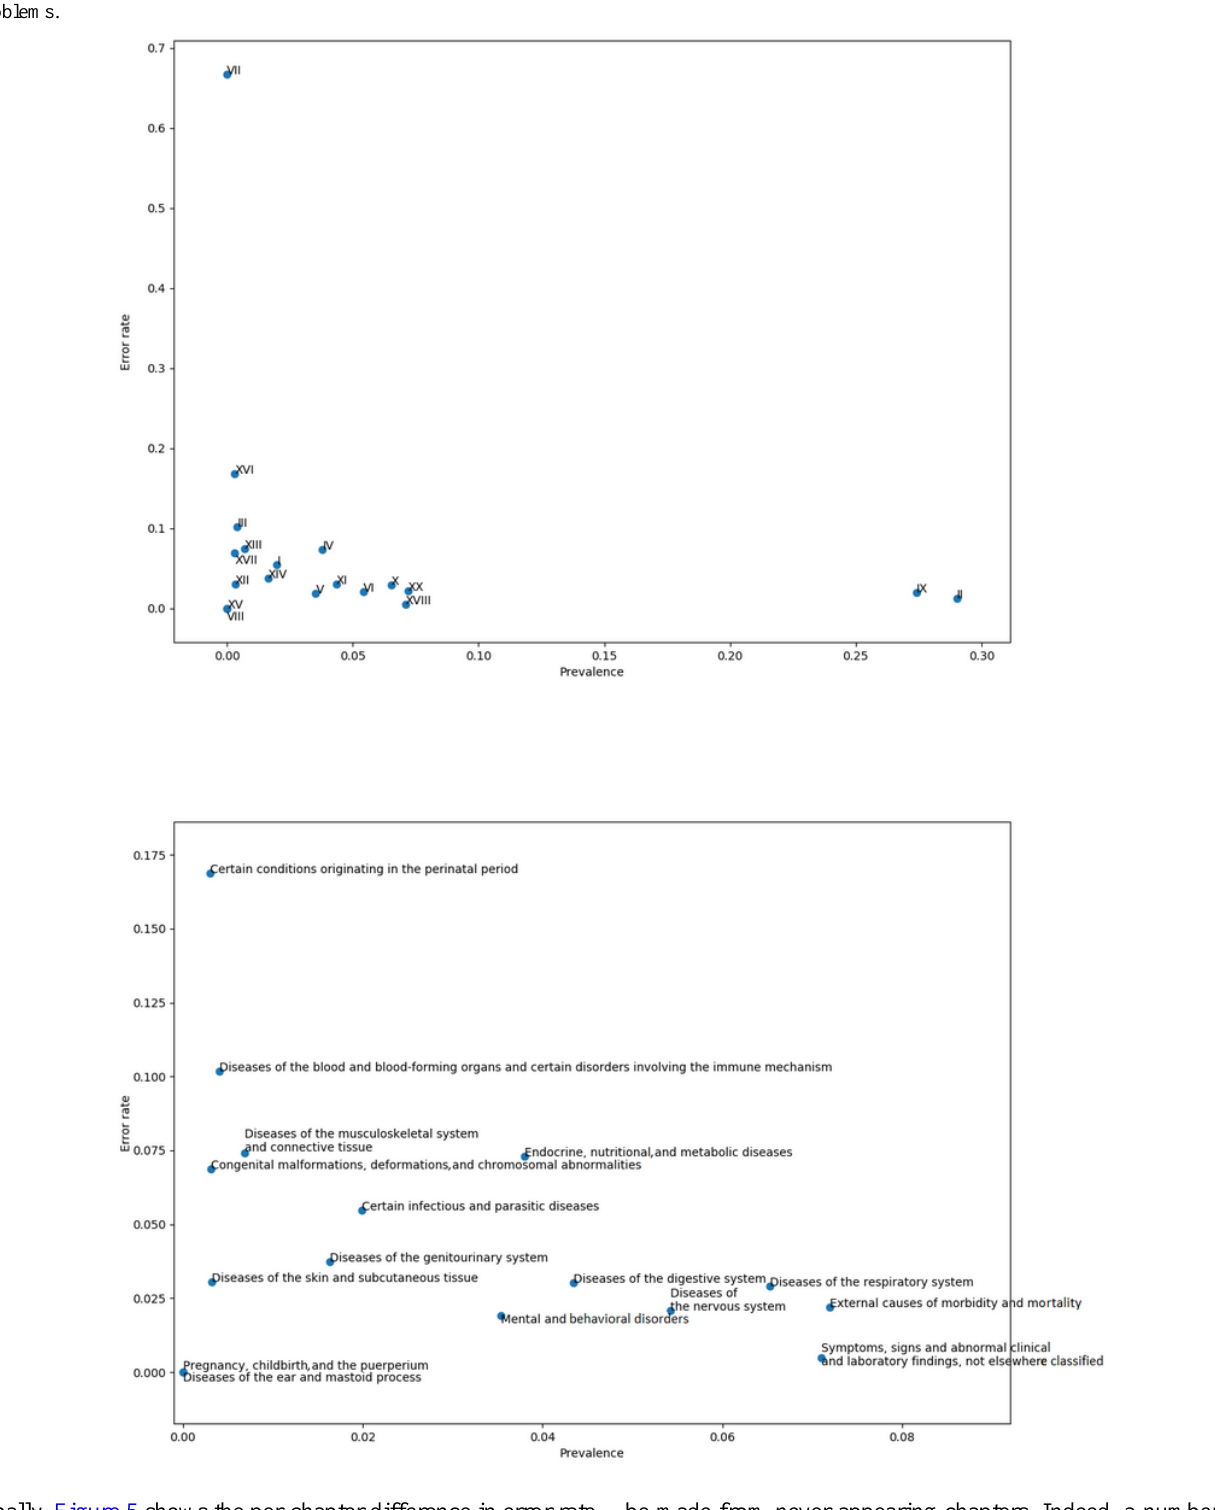
Figure 4. The top plot shows the relevance of underlying causes (by ICD-10 chapter) against ICD-10 chapter−level model error rate. The bottom plot is a zoom on the top plot’s bottom left-hand corner. ICD-10: 10th revision of the International Statistical Classification of Diseases and Related Health